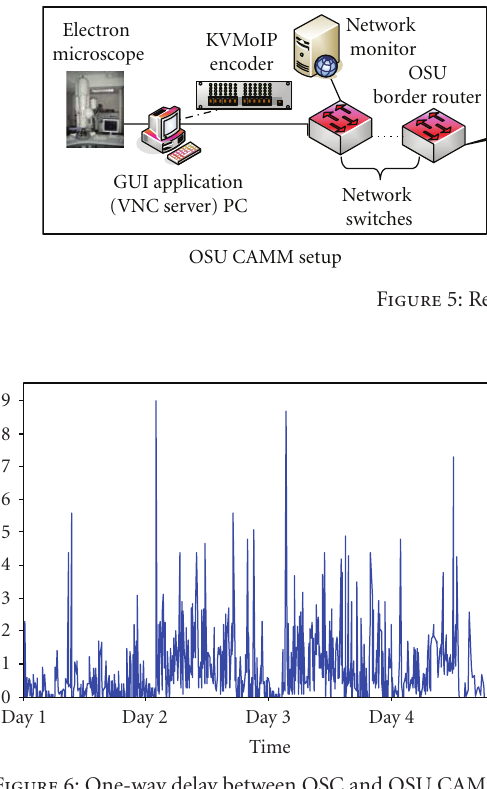
Figure 6: One-way delay between OSC and OSU CAMM.